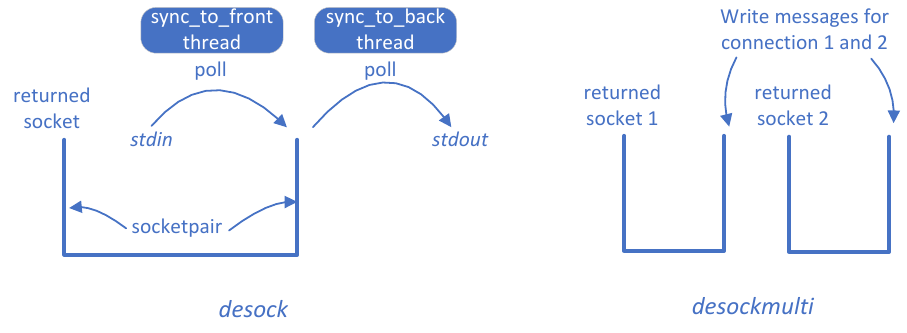
Figure 5. The design of desock and